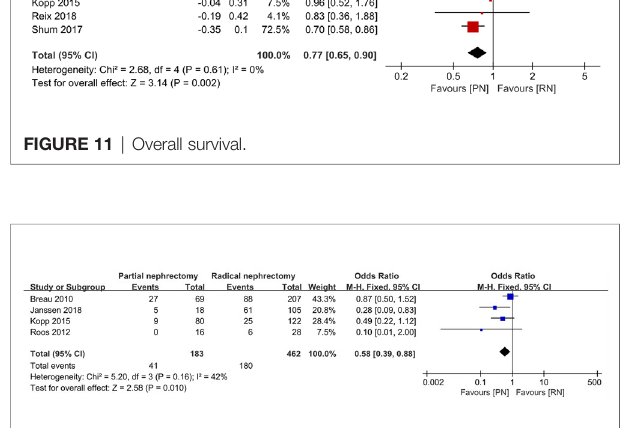
FIGURE 12 | All-cause mortality.